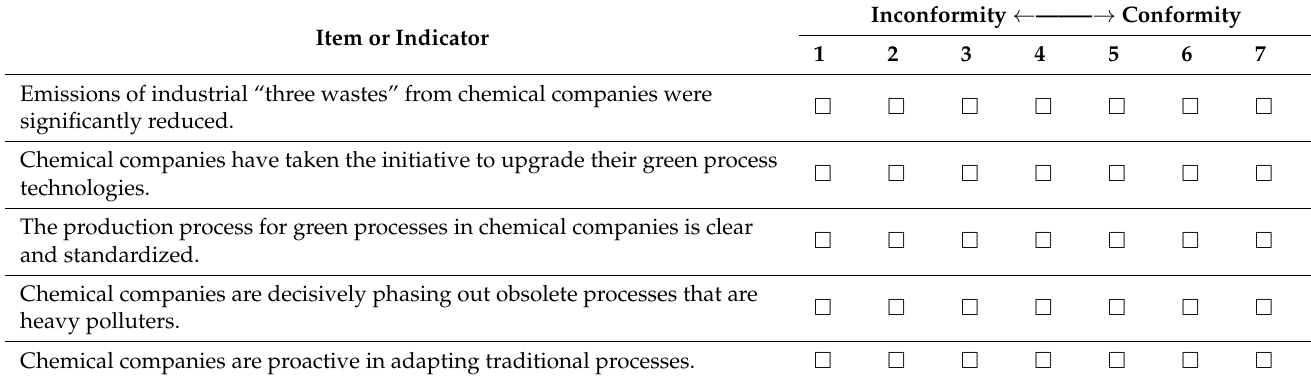
Inconformity ← ——– → Conformity